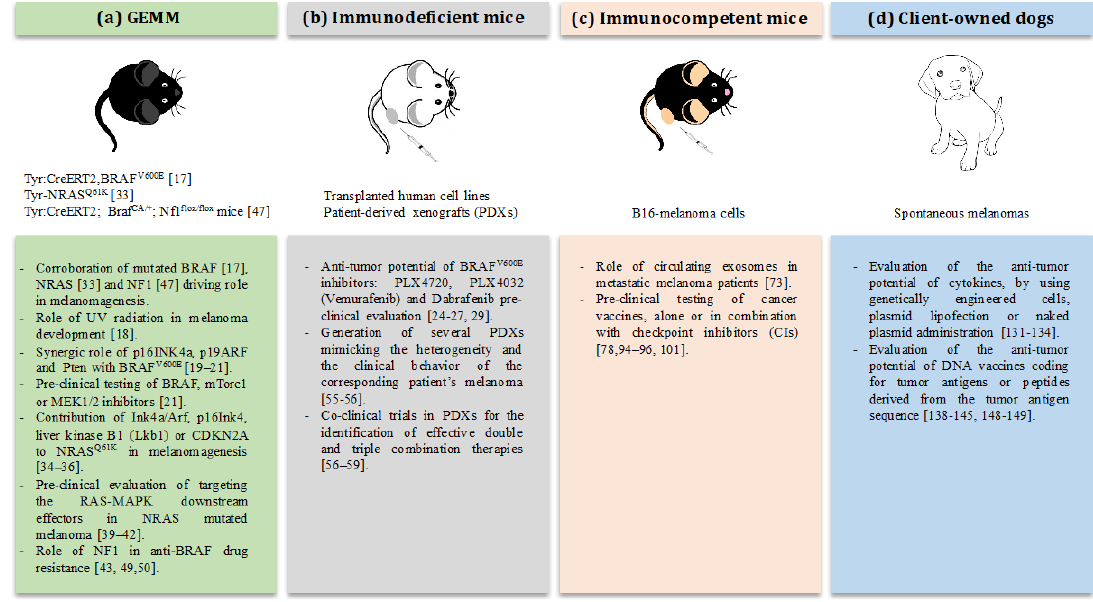
Figure 1. Most relevant achievements in the melanoma onco-immunology field obtained in ( a ) genetically engineered mouse models (GEMM); ( b ) immunodeficient mice xenotransplanted with human cell lines or patient-derived tumors (PDXs); ( c ) immunocompetent mice challenged with syngeneic B16 cells; ( d ) canine patients affected by spontaneous melanoma.